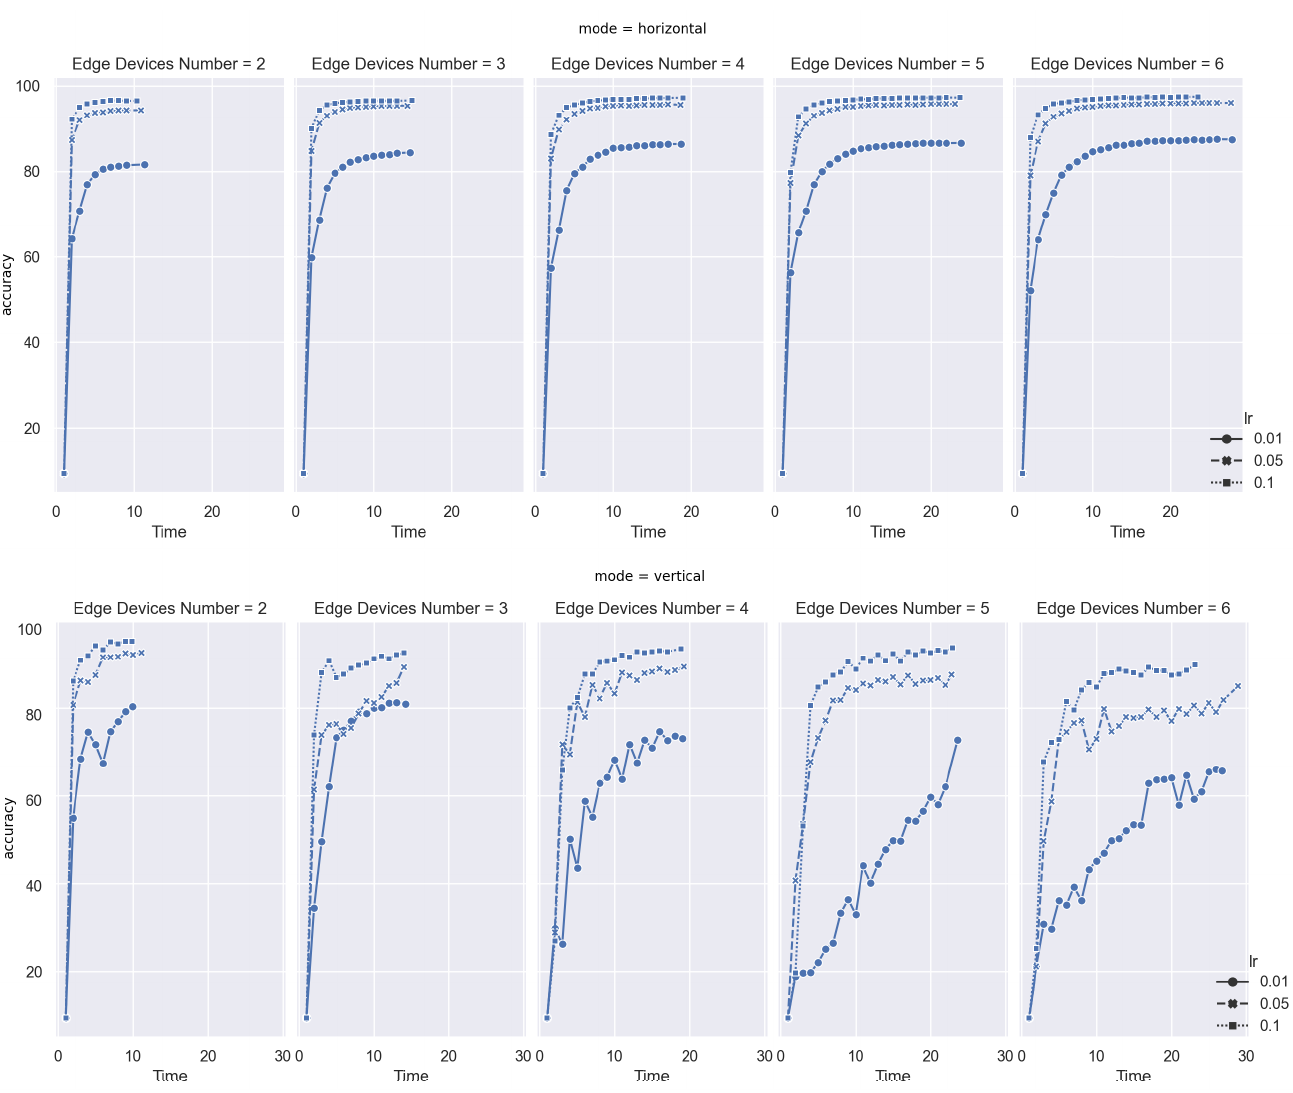
Figure 5. Convergence on Horizontal and Vertical FL in